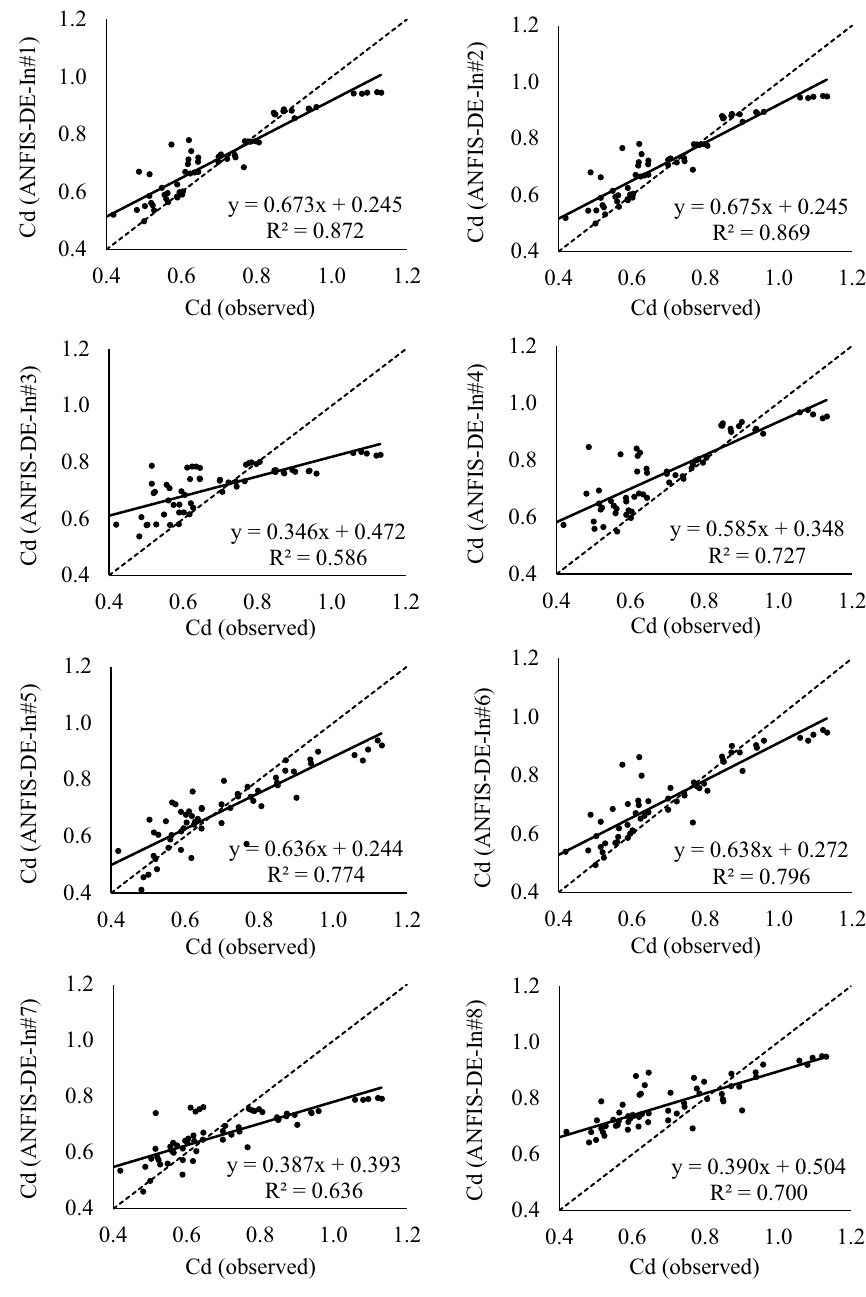
Fig. 7 Scatterplots of ANSIS- DE for various input combina- tions